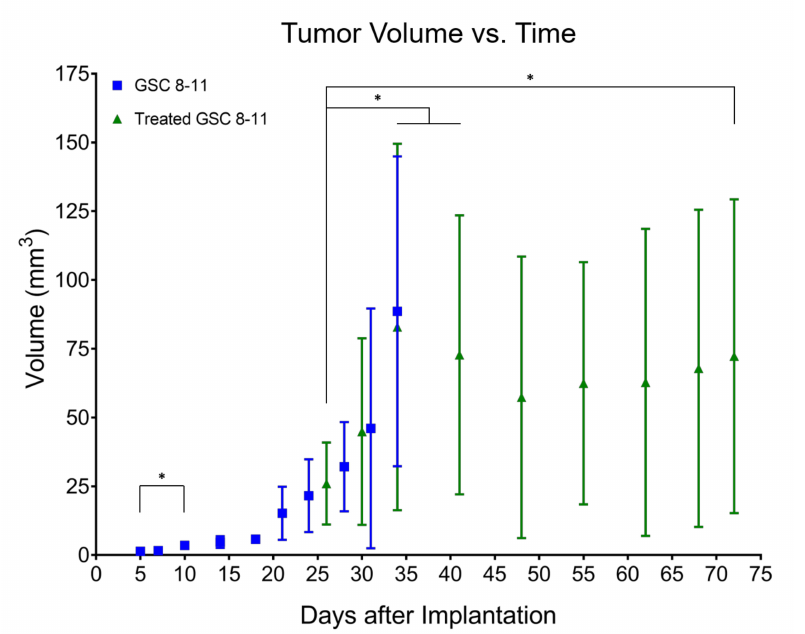
Figure 2. Radiotherapy significantly extends survival of GSC 8-11 tumor-bearing mice. Median survival of treated mice (green line) was significantly higher compared with untreated mice (blue line) (88 vs. 34 days, p < 0.0001). The hazard ratio of untreated-to-treated mice was 4.6. Mice that were euthanized on specific time-points for ex vivo experiments as well as those that died from non- tumor-related causes were censored (black markers). Survival was calculated using Kaplan–Meier analysis. Significant differences between the curves were calculated with the Mantel–Cox logrank test and the hazard ratio using logrank approach.